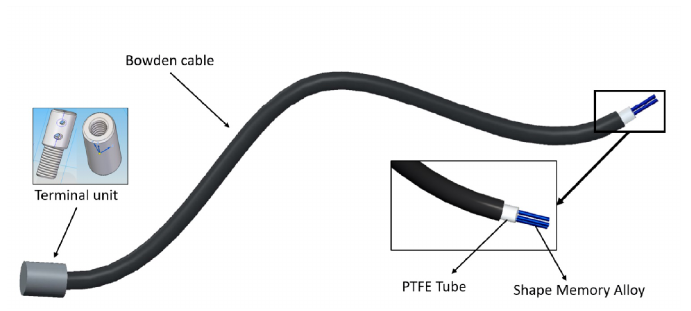
Figure 2. Flexible SMA-based